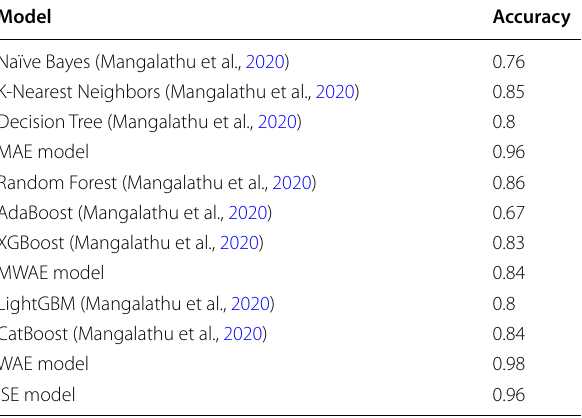
Table 6 Accuracy of various methods.